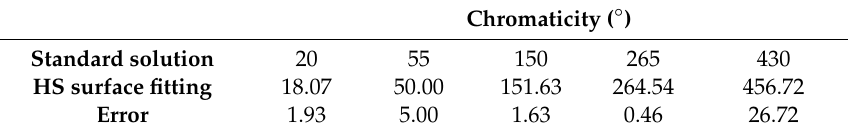
Table 1. Measurements of the standard chromaticity